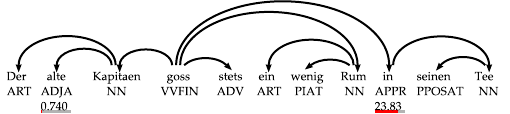
Figure 2 . Surprisal is a word-by-word complexity